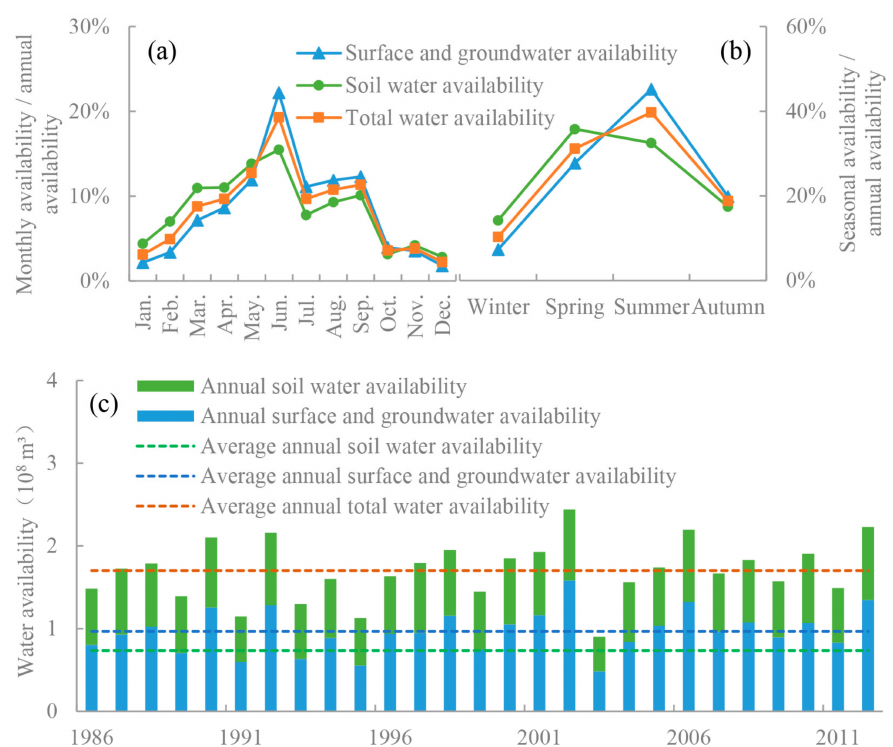
Figure 7. Temporal distribution of ( a ) monthly proportions of freshwater availability; ( b ) seasonal proportions of freshwater availability; and ( c ) yearly freshwater availability.